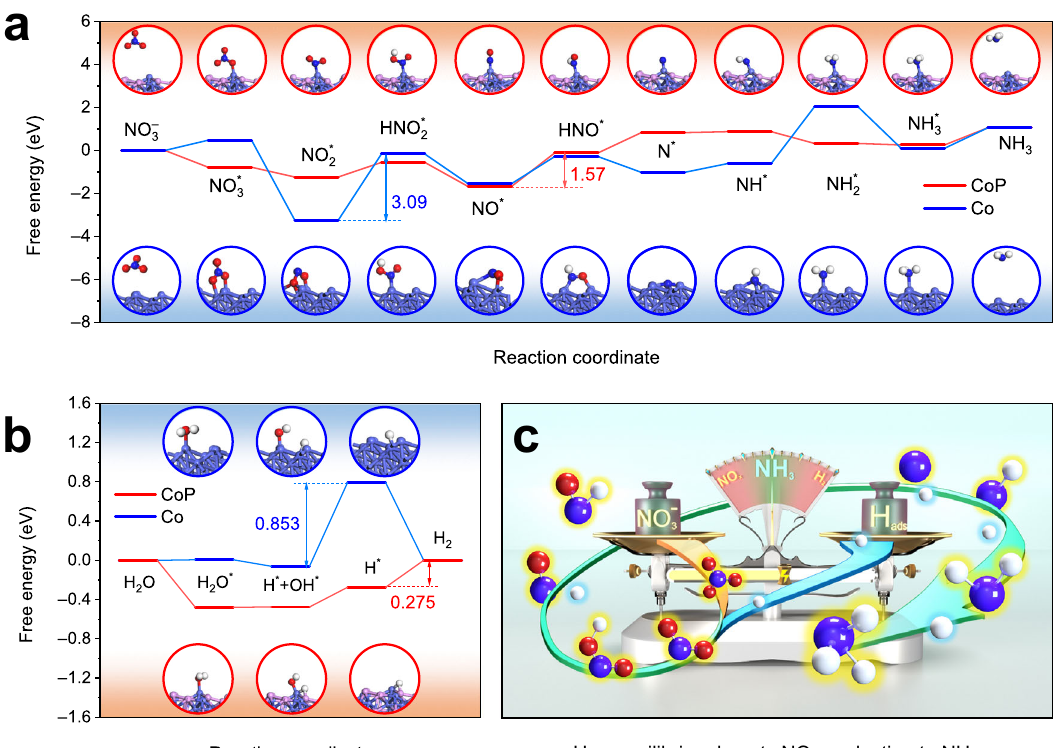
Fig. 5 | DFT calculations. Gibbs free energy diagram via the minimum energy pathway and corresponding adsorption con fi gurations of various inter- mediates generated during a NITRR and b HER process over CoP (211) and Co